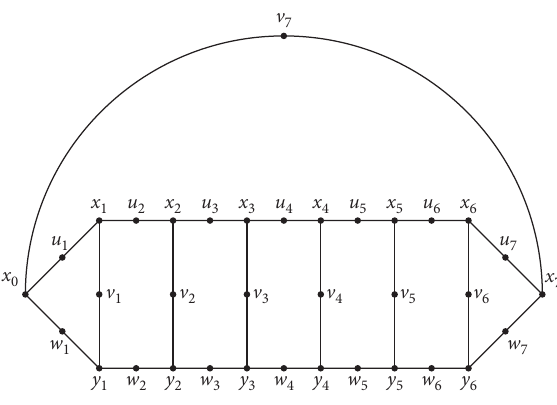
Figure 2: Subdivision of prism graph S ( Y